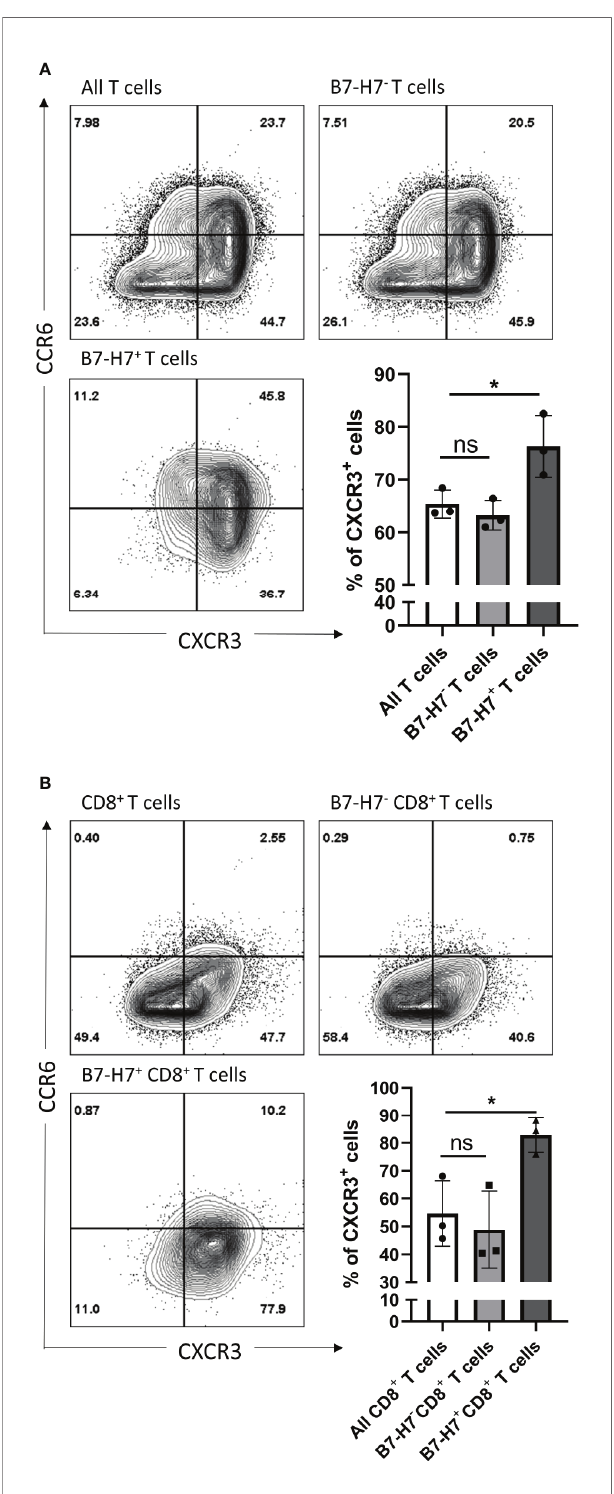
FIGURE 5 | CXCR3 and CCR6 expression pro fi les of total and CD8 puri fi ed T cells. Puri fi ed T cells (A) or puri fi ed CD8 + T cells (B) were activated with recommended dose of TransAct ™ (1:100) for three days, and assessed for B7-H7, CXCR3 and CCR6, n=3. Cells were gated for live and single cells. ns, not signi fi cant, *p < 0.05, one-way ANOVA was used, followed by multiple comparison